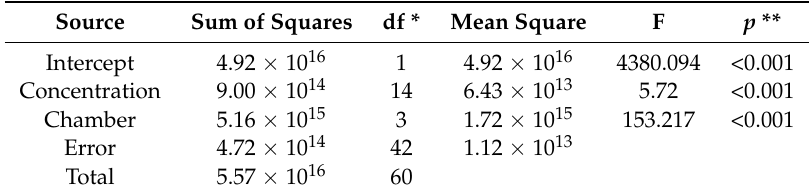
Table 7. ANOVA for RBD. Dependent variable: ∆ Z . f = 60,016